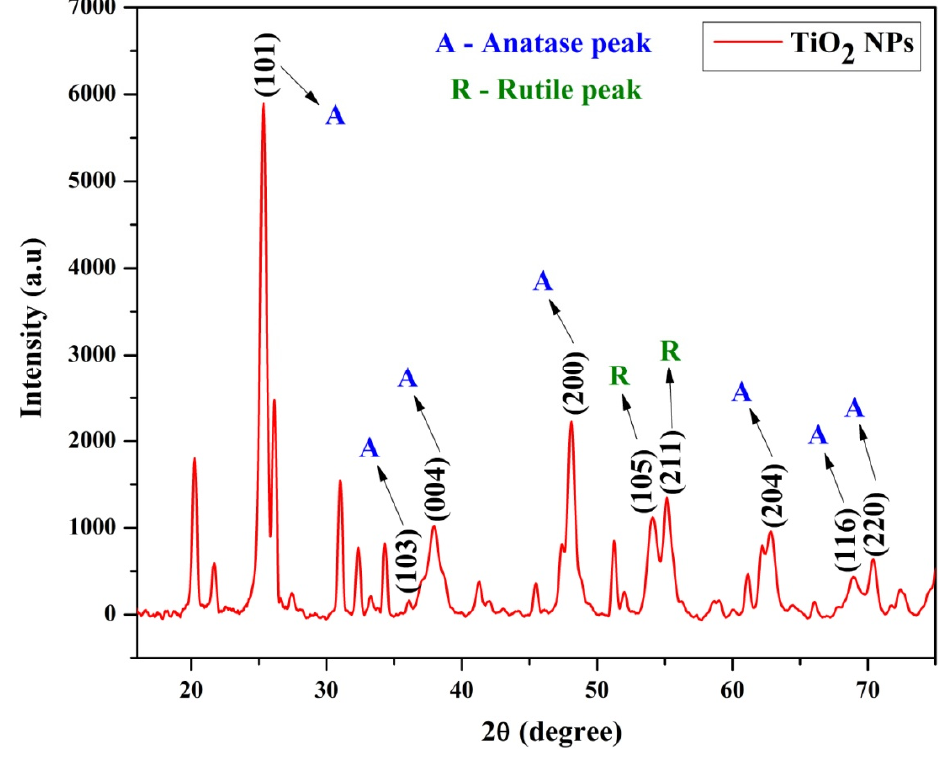
Figure 1. XRD analysis of TiO 2 nanoparticles.